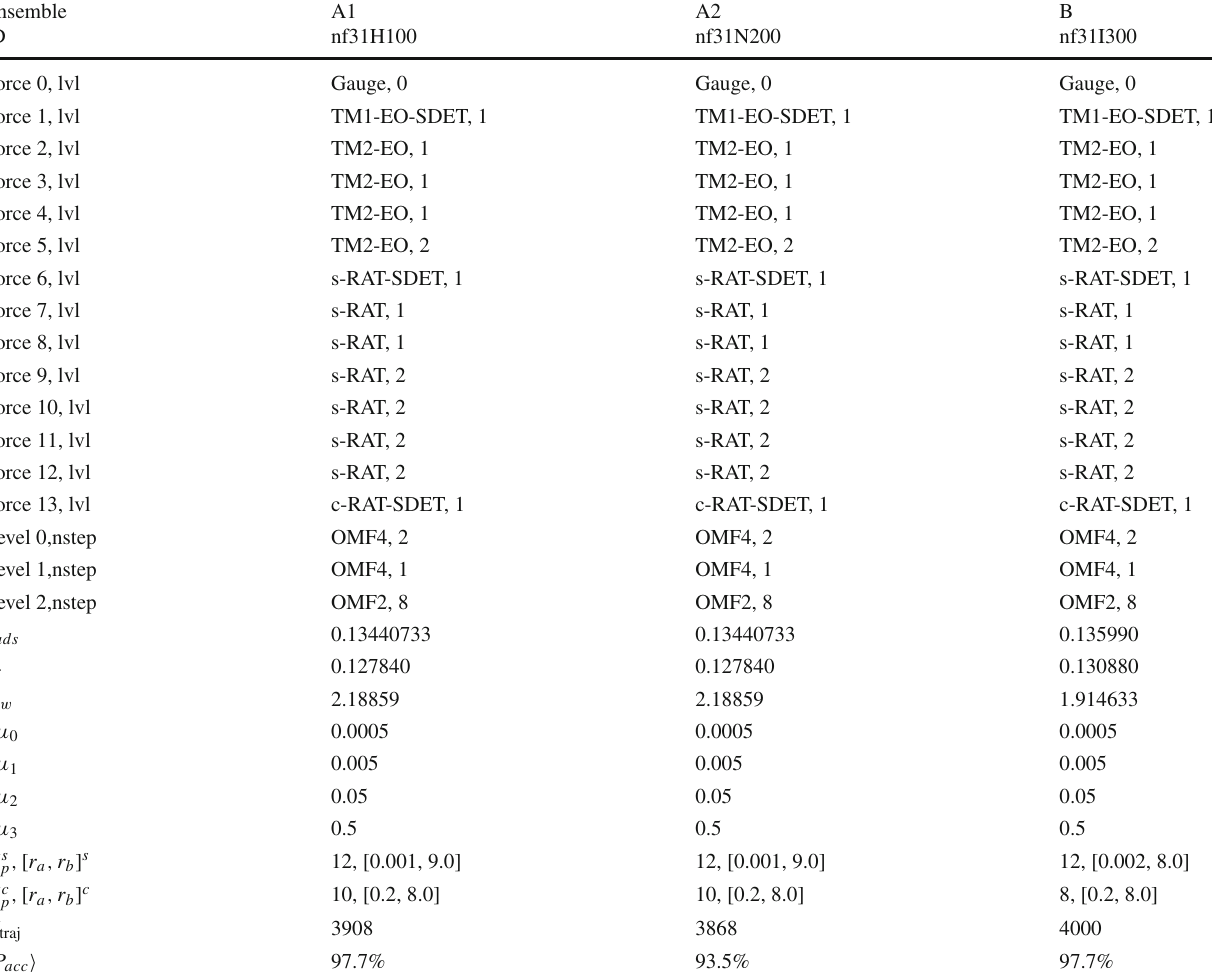
Table 9 Parameters of the algorithm: We give the forces used for the gauge and fermion fields with their integration levels, the integrators for the different levels and number of steps per trajectory resp. outer level,